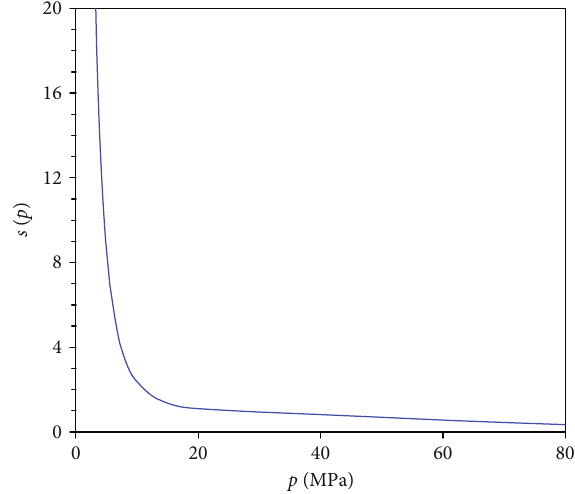
Figure 18: The relation curve of g ð p Þ vs. p for the high-pressure cases.